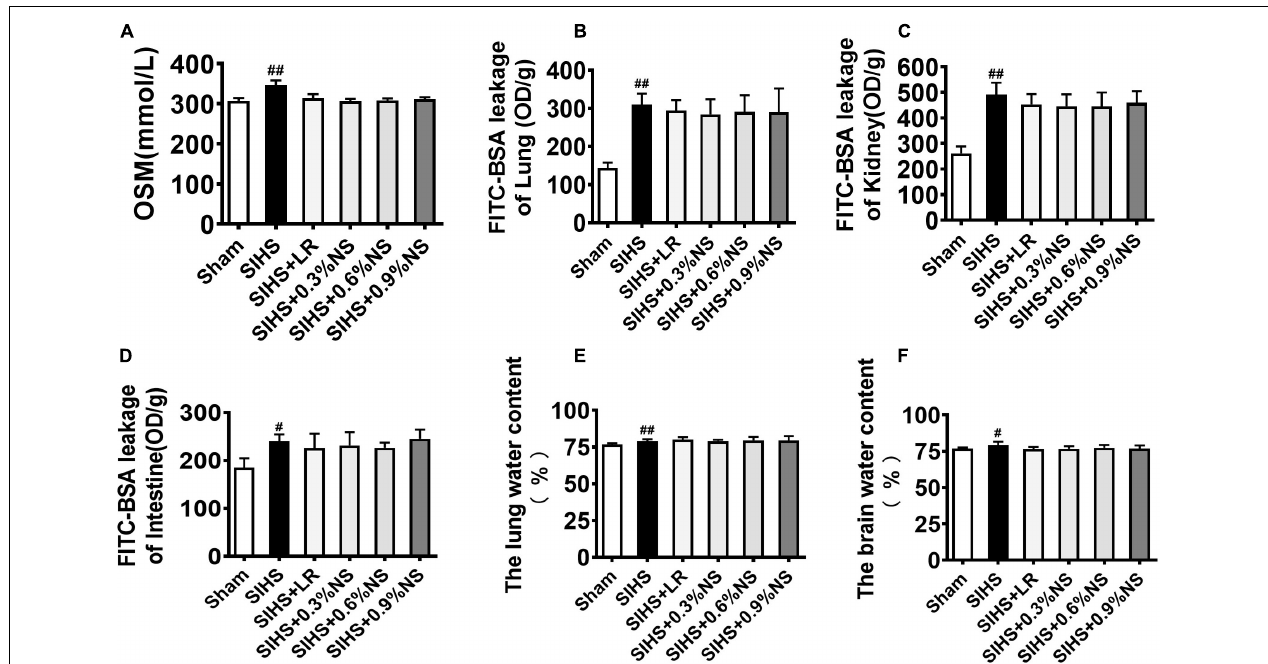
FIGURE 5 | Effects of different osmotic fluids on blood osmotic pressure, vascular permeability, and tissue edema of vital organs in SIHS rats. (A) Plasma osmotic pressure. (B) Fluorescein isothiocyanate-labeled bovine serum albumin (FITC-BSA) leakage of the lung. (C) FITC-BSA leakage of the kidney. (D) FITC-BSA leakage of the intestine. (E) Lung water content. (F) Brain water content. FITC-BSA enters the blood circulation from the jugular vein and then leaks into the lungs, kidneys, and intestines. FITC-BSA leakage of lung/kidney/intestine was used to represent the permeability of lung/kidney/intestine. Sham, Sham-operated group; SIHS, seawater immersion combined with hemorrhagic shock; LR, lactated Ringer’s solution; NS, normal saline. # p < 0.05 and ## p < 0.01, compared with the Sham group.